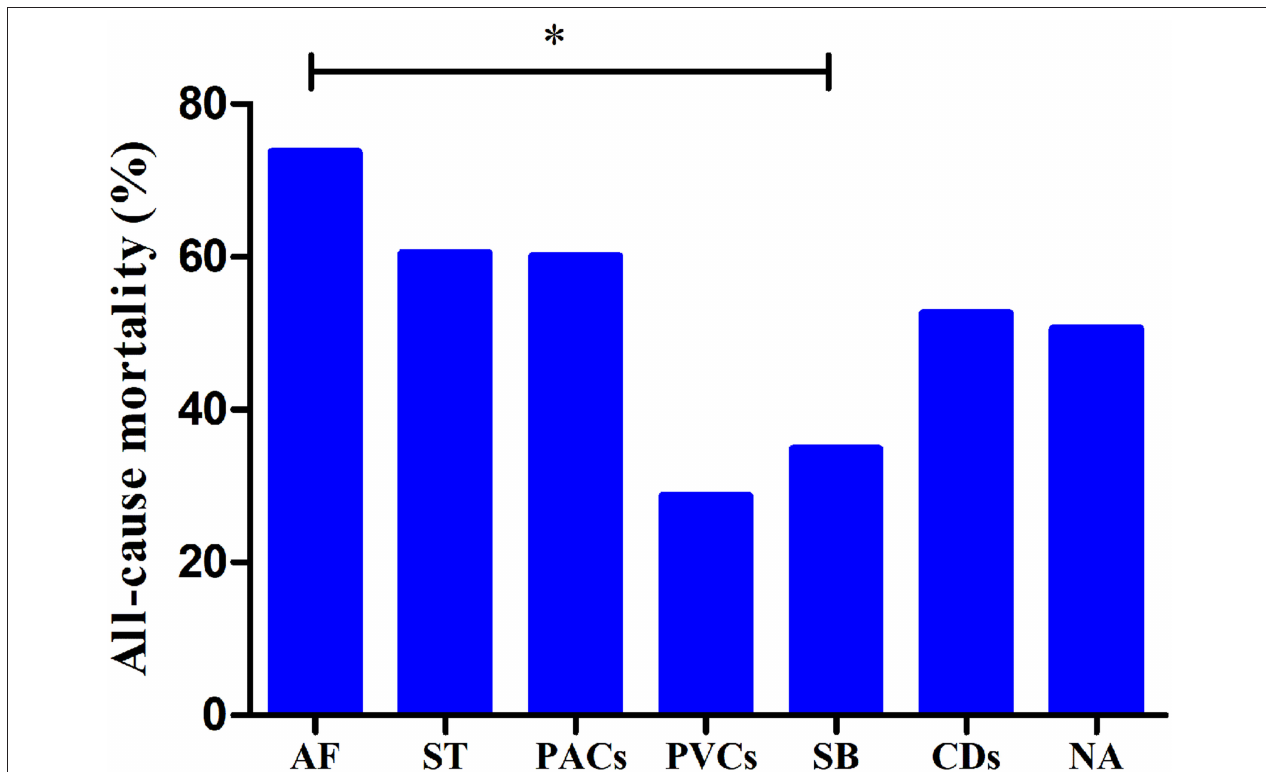
FIGURE 2 | All-cause mortality rates in patients with different types of arrhythmias. * P < 0.01; AF, atrial fibrillation; ST, sinus tachycardia; PACs, premature atrial contractions; PVCs, premature ventricular contractions; SB, sinus bradycardia; CDs, conduction disorders; WOAs, without